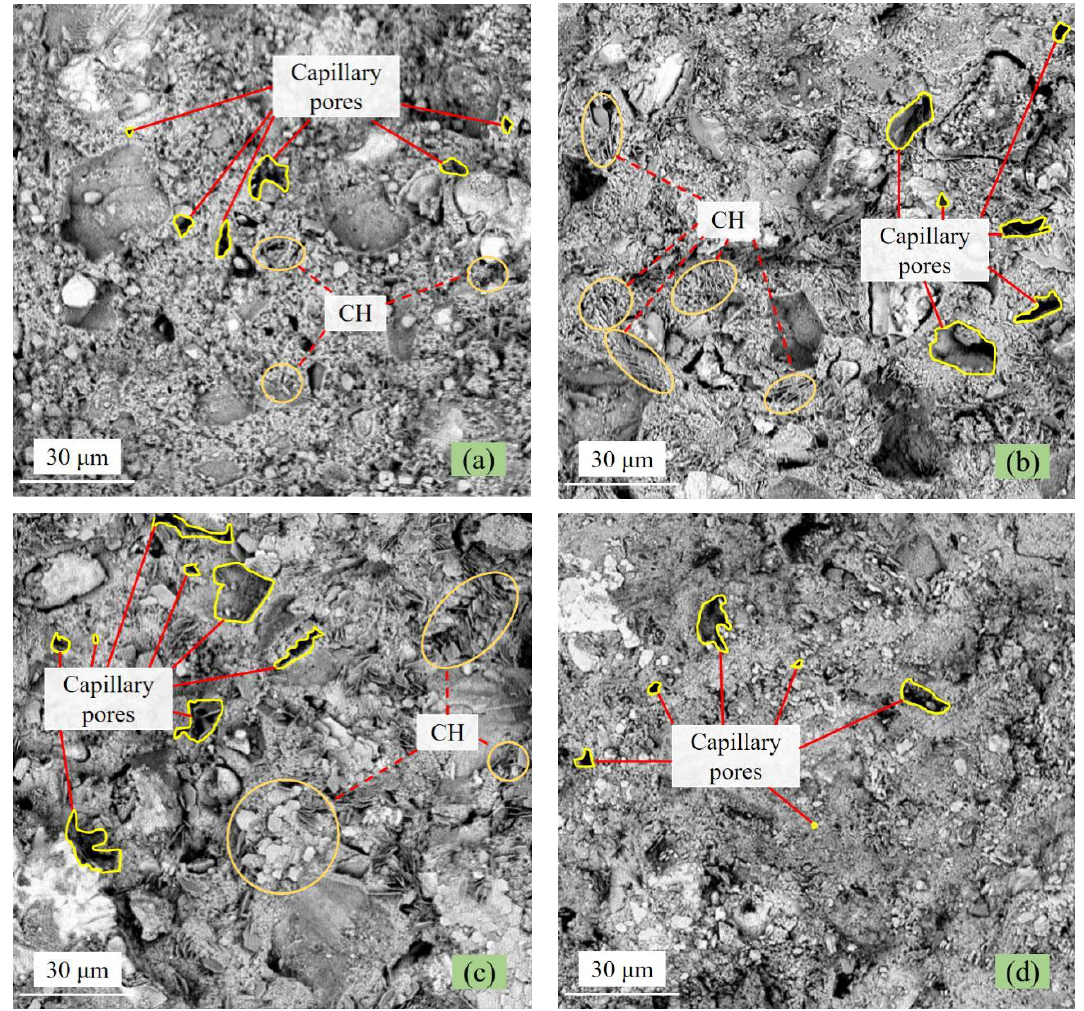
Figure 12. Microstructure of cement stone using SEM: ( a ) w/c = 0.40, 1 day; ( b ) w/c = 0.44, 1 day; ( c ) w/c = 0.50, 1 day; ( d ) w/c = 0.50, 7 days.